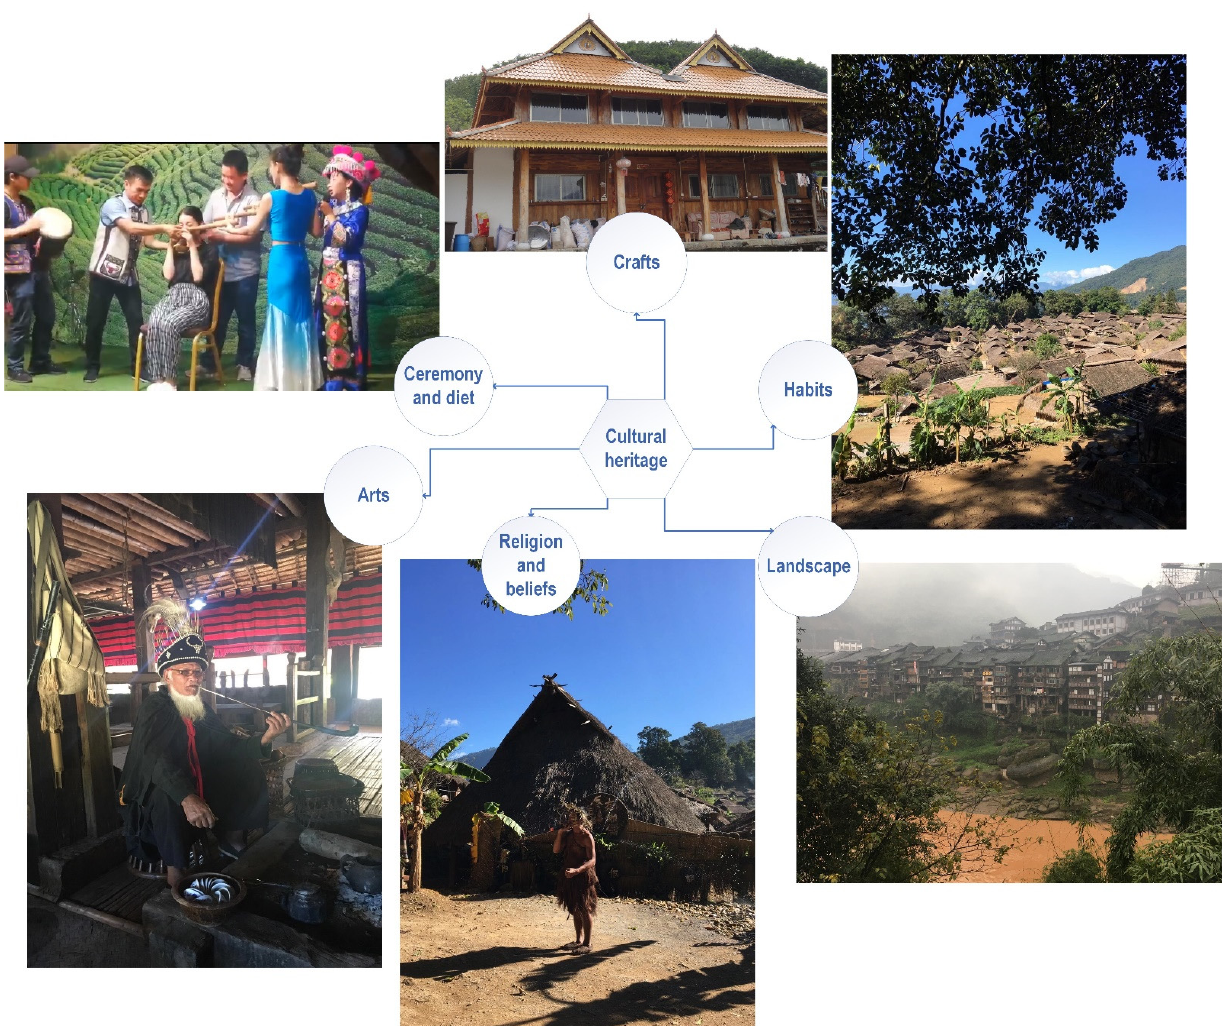
Figure 5. Rural areas maintain many aspects of the cultural heritage of China (photos © authors).